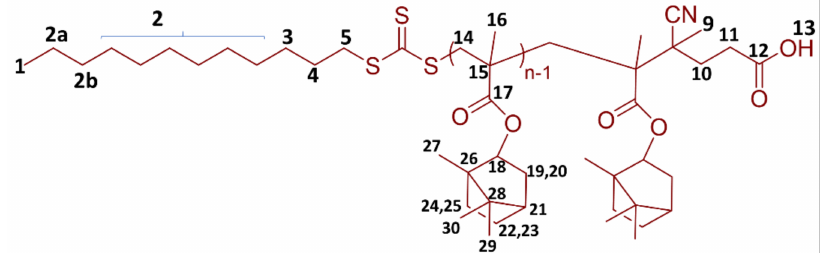
Scheme 2. Schematic representation PIBOMA macromolecule with numbering for NMR